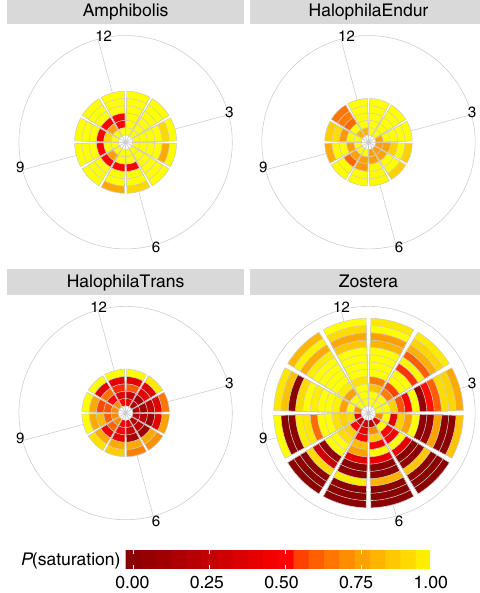
Fig. 4 The probability of above saturation light conditions for the 28 global sites studied here, grouped by genus and life history of seagrass genera. Each ring represents one site, each pie slice represents one month of the year (labelled numerically in outer ring, 12 corresponds to December), aligned to Austral summers